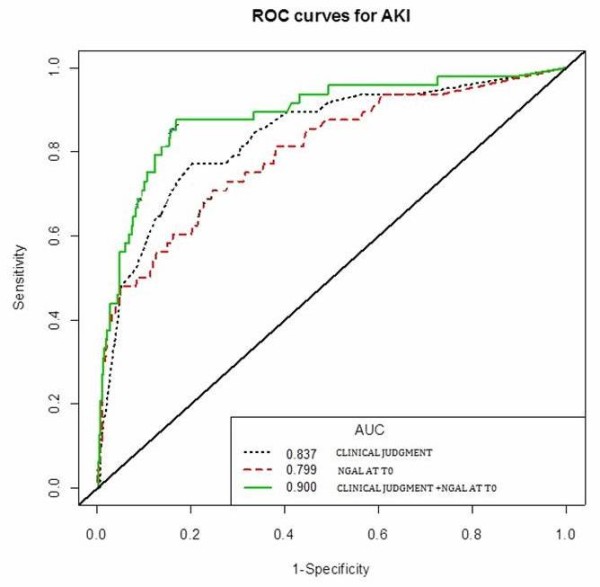
T0 receiver-operating characteristic (ROC) curves by adjudicated acute kidney injury (AKI) based on neutrophil gelatinase-associated lipocalin (NGAL), clinical judgment of developing AKI, and NGAL combined with clinical judgment.